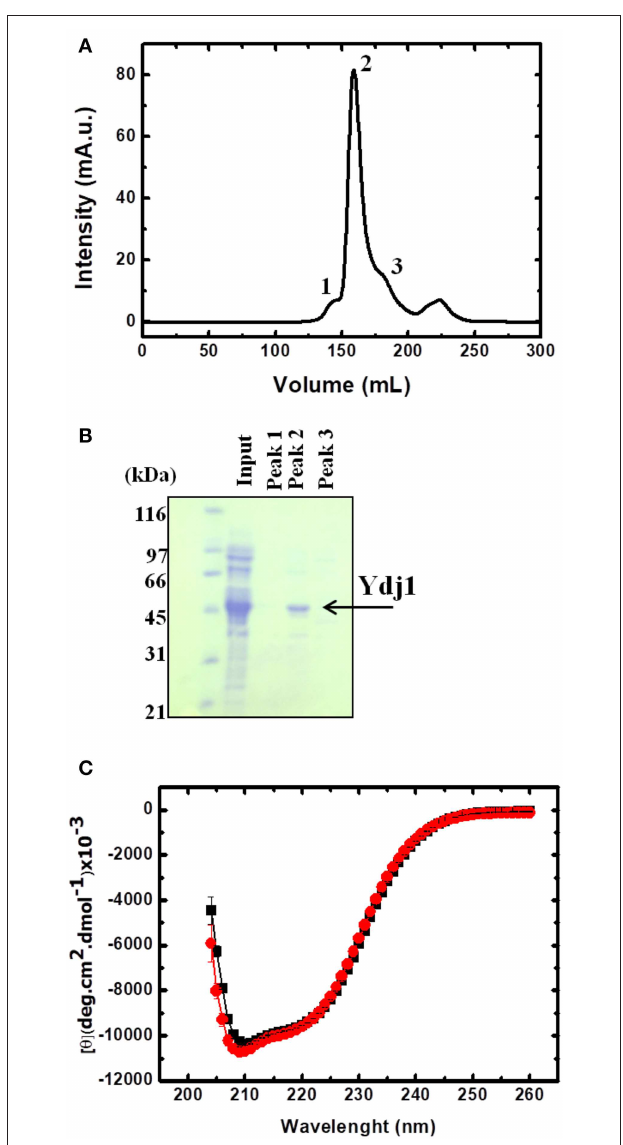
FIGURE 3 | Production and purification of folded Ydj1. (A) Chromatogram of the last purification step. Peaks were labeled 1 to 3 and verified by SDS-PAGE (B) . Sample from peak 2 contained purified Ydj1. Molecular mass standard is on the left. (C) Folded Ydj1 was produced, as verified by its far-UV CD spectrum (red). Ydj1 remained folded after the Zn removal procedure (see text for details), as verified by its far-UV CD spectrum (black).